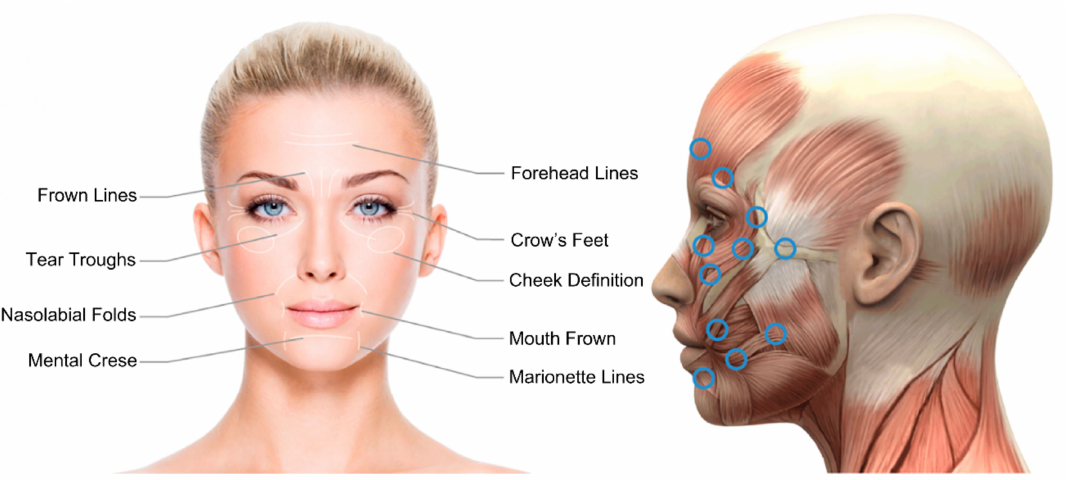
Figure 4. Skin stimulation point positioning (source: https://skincaredenver.com/ (accessed on 25 May 2021)) [17].